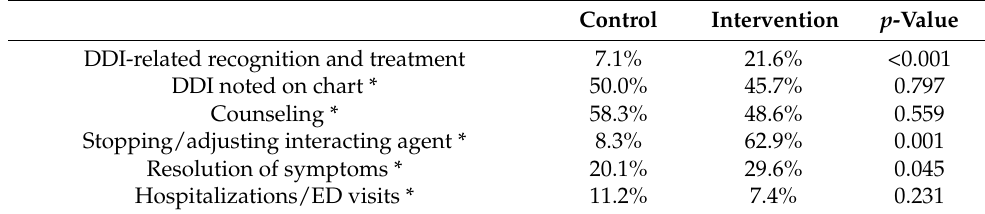
Table 3. Primary and secondary